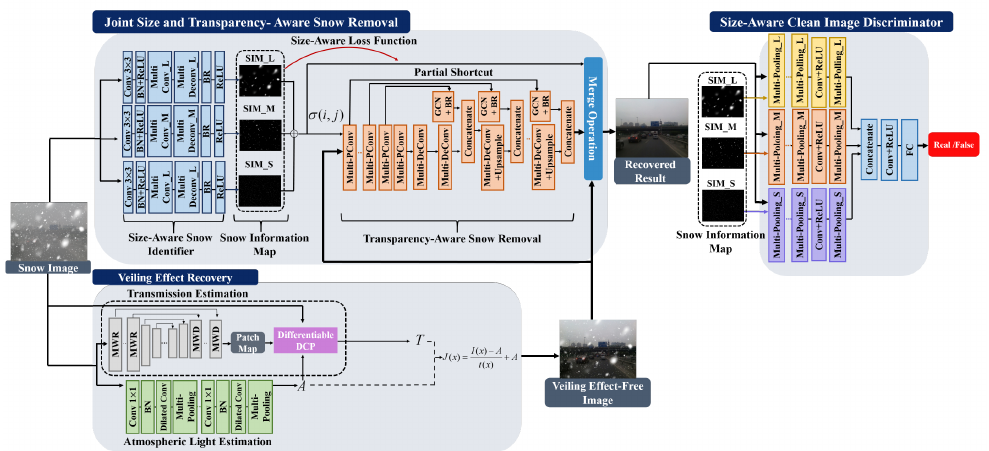
Figure 6. Schematic of the JSTASR method by Chen et al. [32]. The model comprises three modules. First, it contains a joint size and transparency-aware snow removal module. Secondly, it employs a veiling effect recovery module, and finally it comprises a size-aware clean image discriminator.